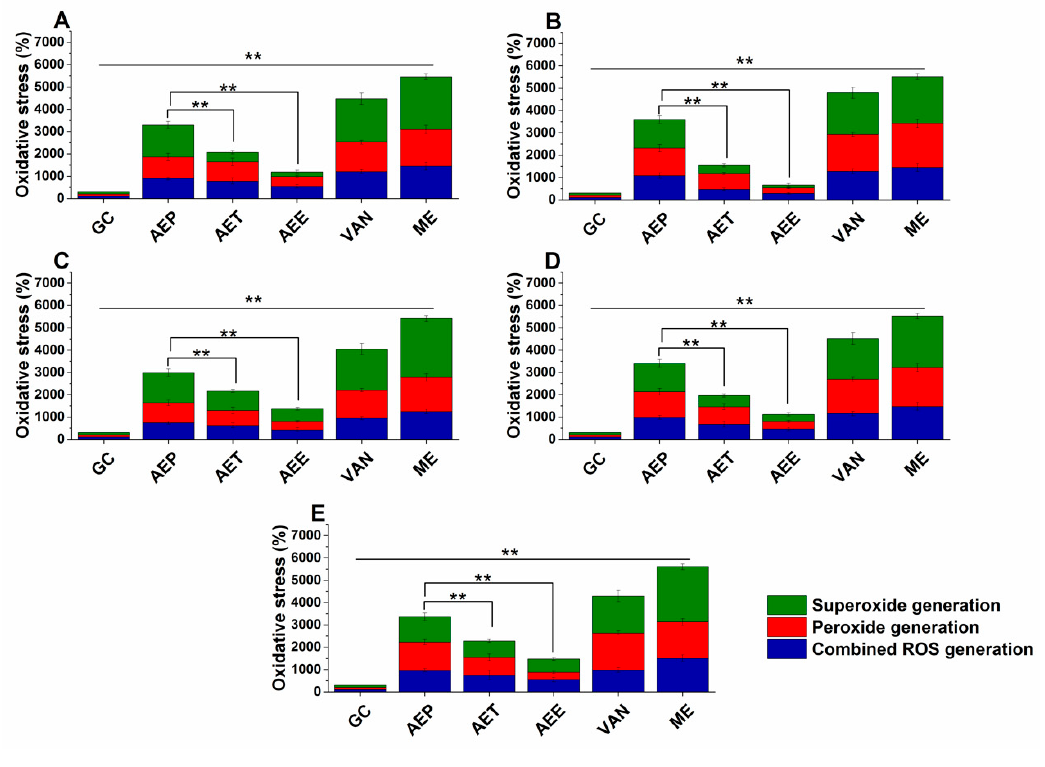
Figure 7. Percentage oxidative stress generation by AEP, AET, AEE, and VAN on E. coli ( A ), S. aureus ( B ), B. subtilis ( C ), P. aeruginosa ( D ), and S. pyogenes ( E ) at their respective MEC 10 concentrations after one-hour treatment. All results were compared to those for menadione (ME) and growth control (GC). The three formulations were evaluated separately as well. Six independent experiments, each with three technical replicates (** P < 0.01, mean ± SD).